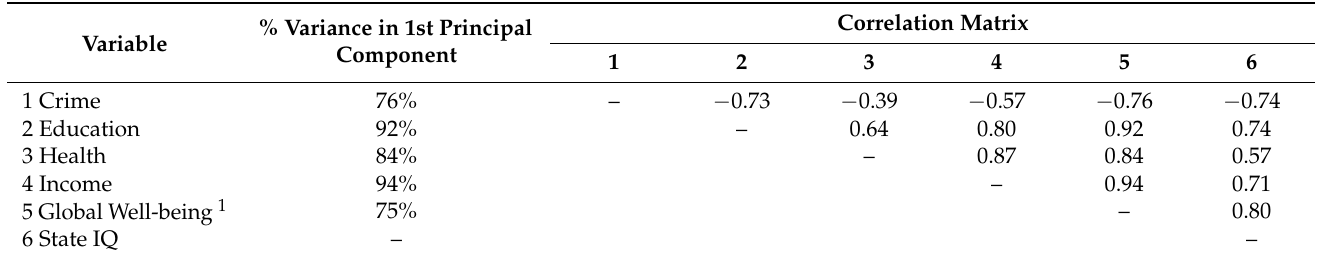
Table 1. Correlation matrix and principal components analysis for the well-being sub-domains plus state IQ.